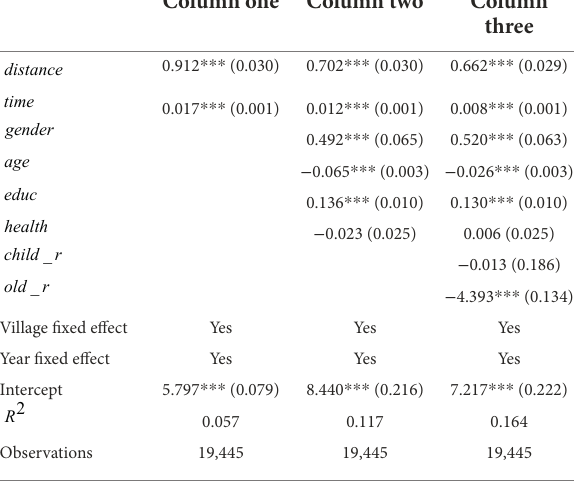
TABLE 3 IV estimation results of the first stage. Column one Column two Column